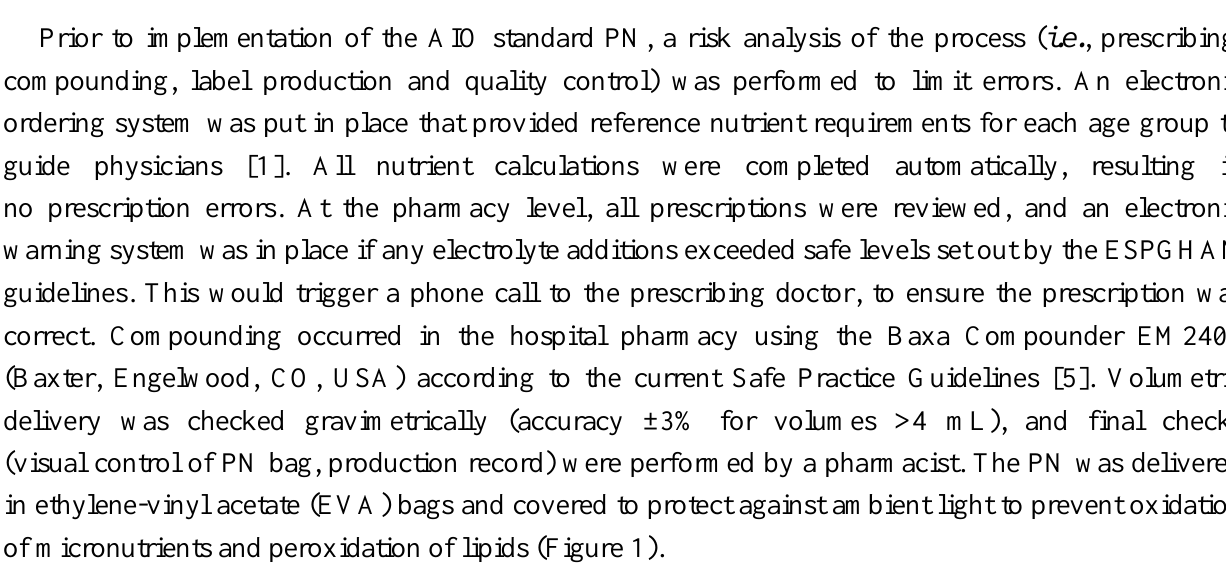
Figure 1. Illustration on PN solutions and how they were delivered to the ward: (1) is the AIO PN bag; (2) the giving sets and filter used and (3) the light protection and bar coded label for a standard PN